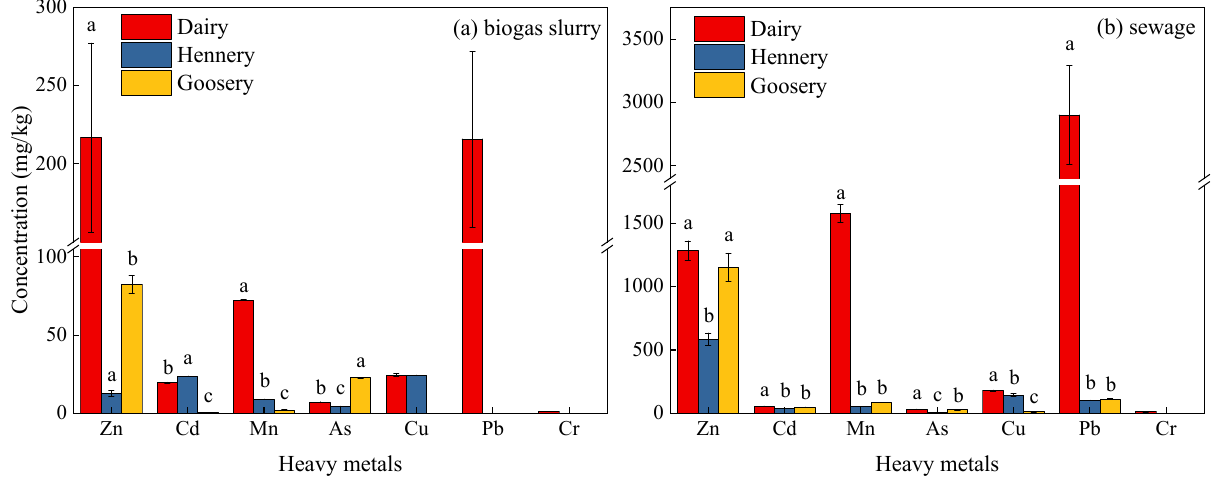
Figure 4. Concentrations of heavy metals in biogas slurry ( a ) and sewage ( b ) from three types of farms. Different letters indicate significant differences between different types of farms ( p < 0.05).